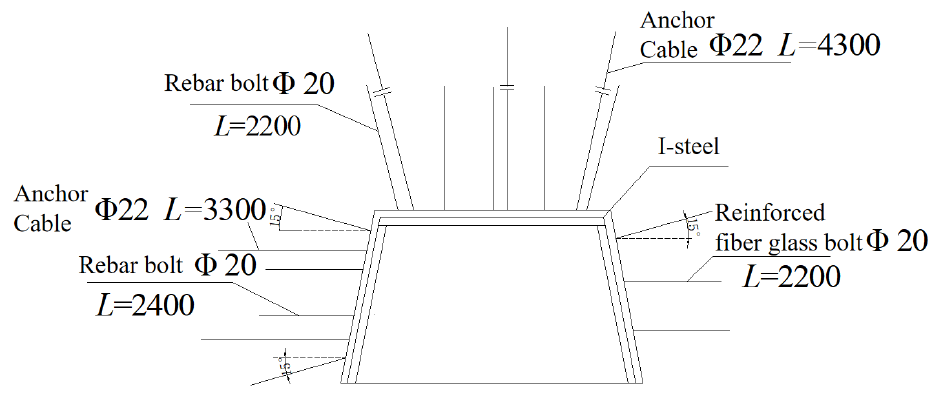
Figure 18. Roadway section support